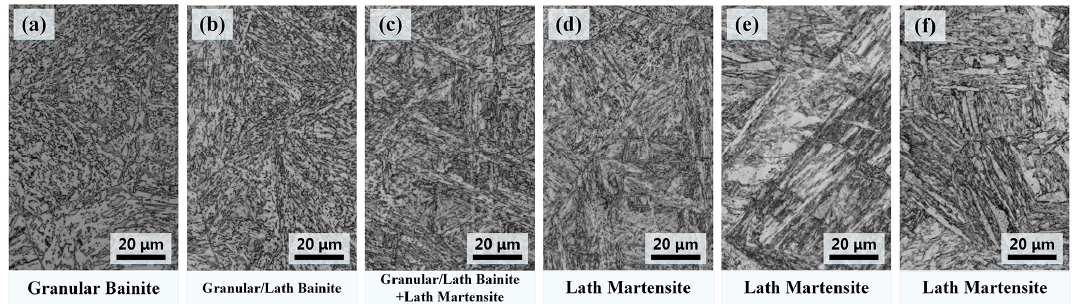
Figure 14. Optical micrographs of the t / 2 specimens after continuous cooling at ( a ) 0.2 ◦ C / s, ( b ) 0.5 ◦ C / s,